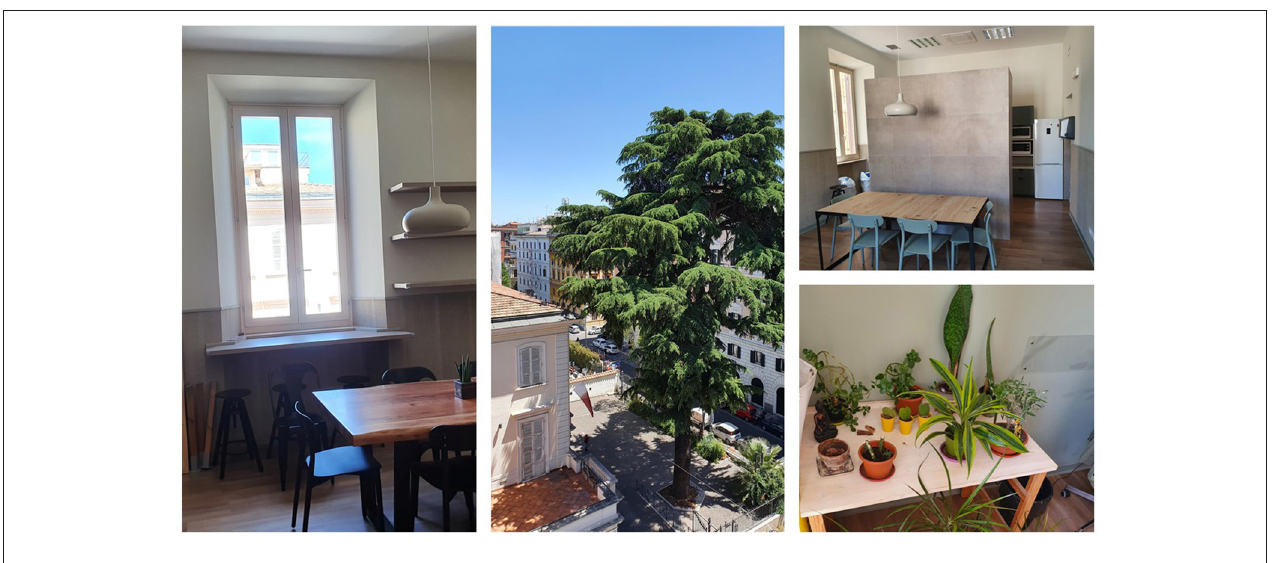
FIGURE 3 | Some views of the new headquarters.